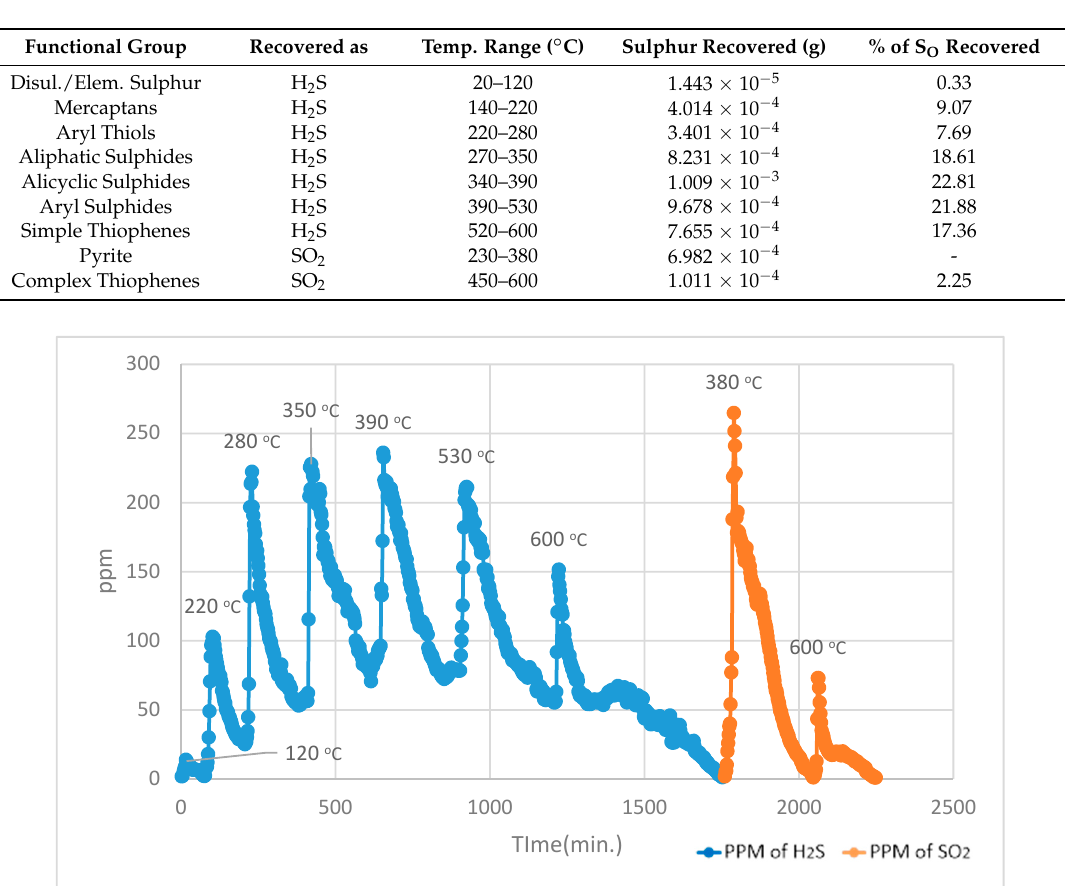
Table 11. Results for the TPI of mequinenza lignite.